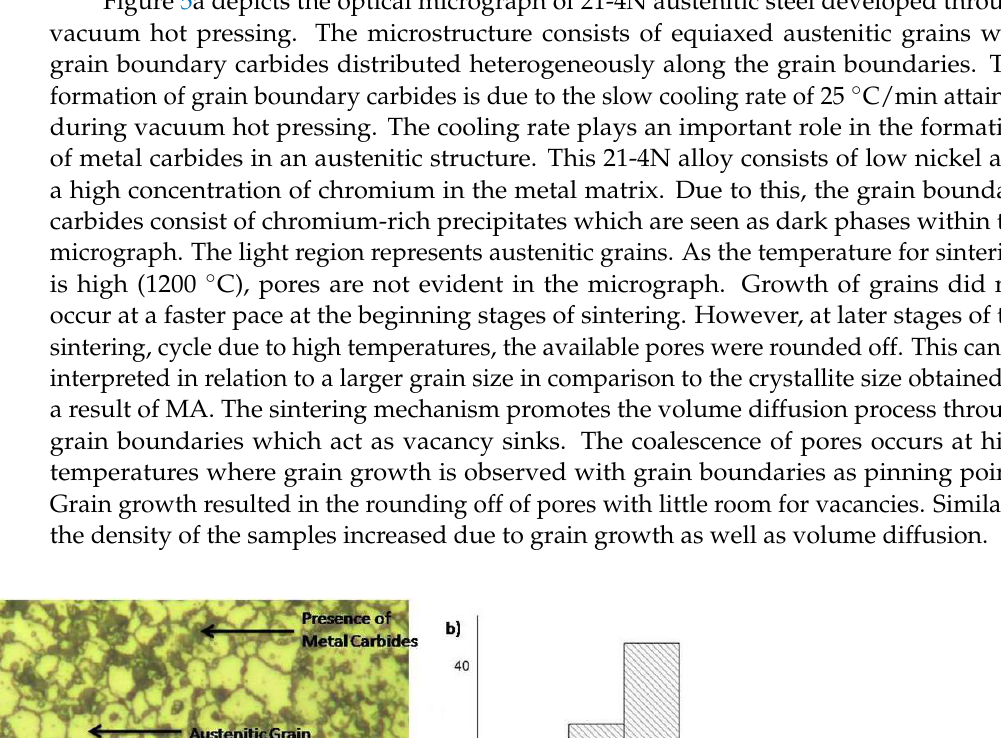
Figure 4. Density of hot pressed samples developed through powder metallurgy route.